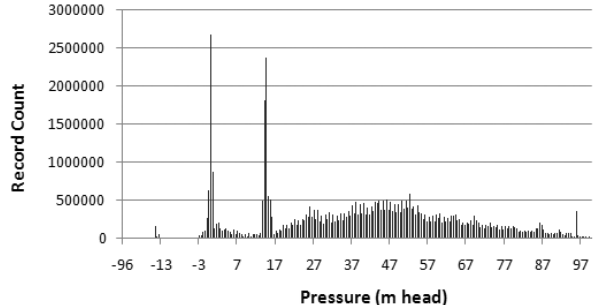
Figure 11. Distribution of pressure